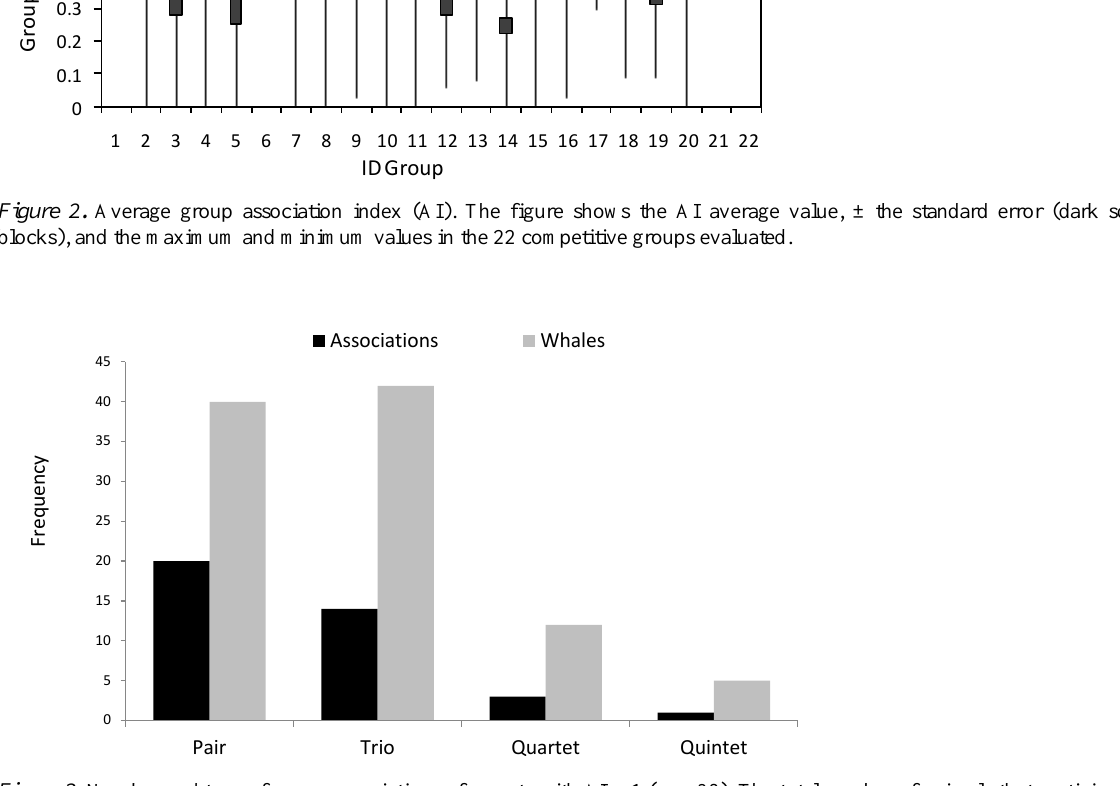
Figure 3. Number and type of group associations of escorts with AI = 1 ( n = 38). The total number of animals that participated in these subunits was